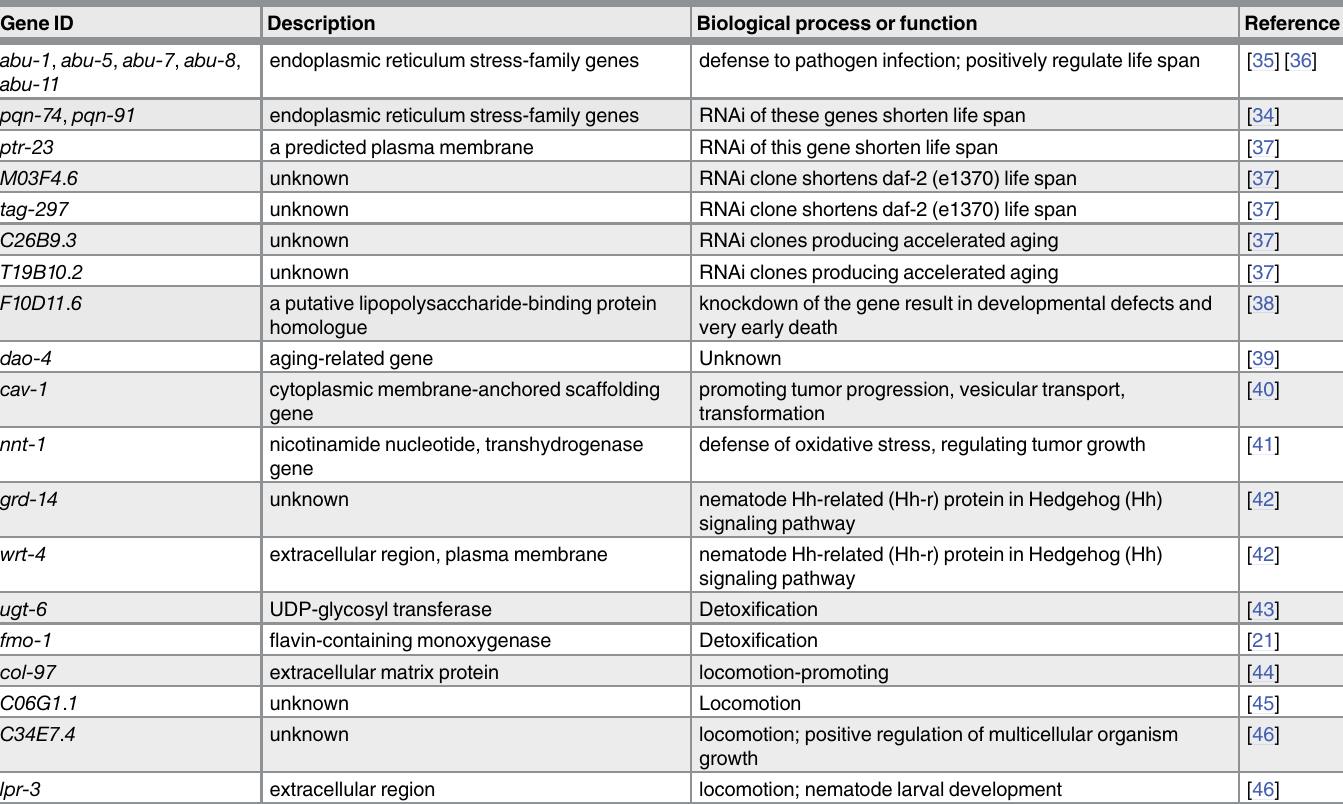
Table 1. List of differentially expressed genes and their physiological functions. Gene